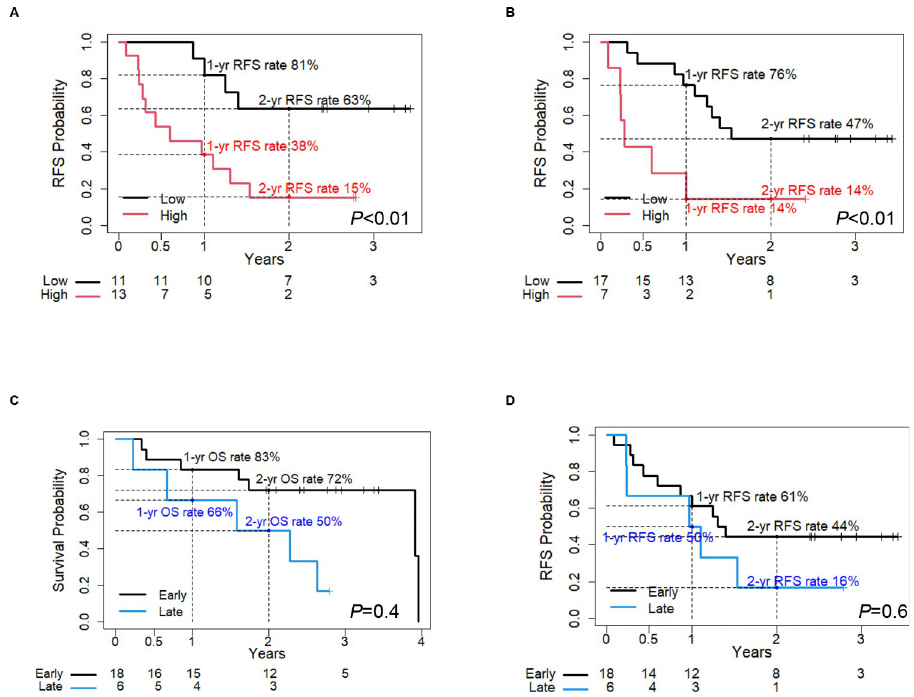
Fig 4. Relapse-free survival rates of high expression of PODXL and ITGB1, and UICC TNM stage. (A, B) Kaplan- Meier analysis of postoperative RFS rates according to (A) PODXL expression and (B) ITGB1 expression. (C, D) Kaplan-Meier analysis of postoperative (C) OS rate and (D) RFS rate according to UICC TNM stage (early: UICC stage IA-IIA; late: UICC stage IIB-III).